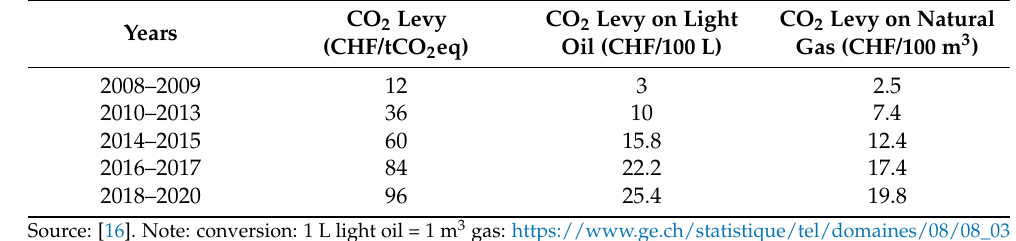
Table 1. Swiss CO 2 levy